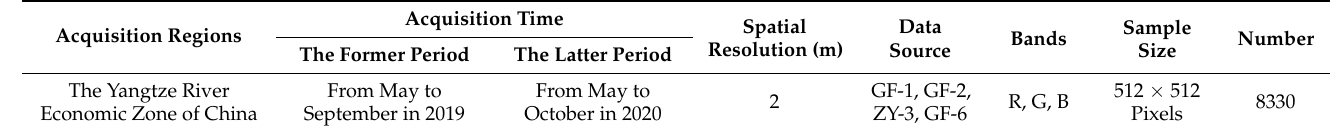
Table 3. The meta-information of the high-resolution deforestation detection